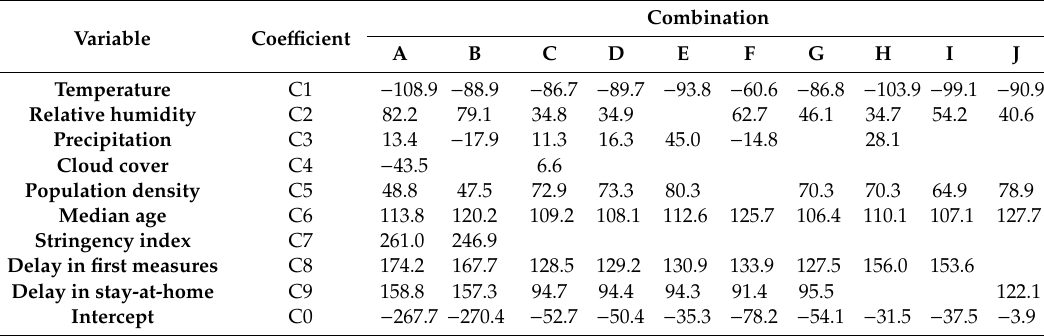
Table 3. Calculated values of regression coe ffi